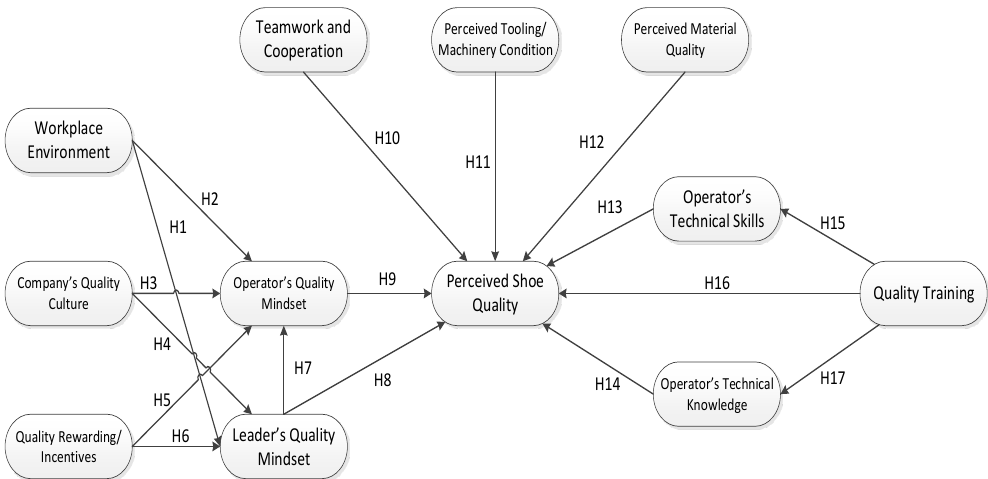
Figure 1. Conceptual framework of the factors affecting perceived product quality. Table 1. The hypotheses construct.